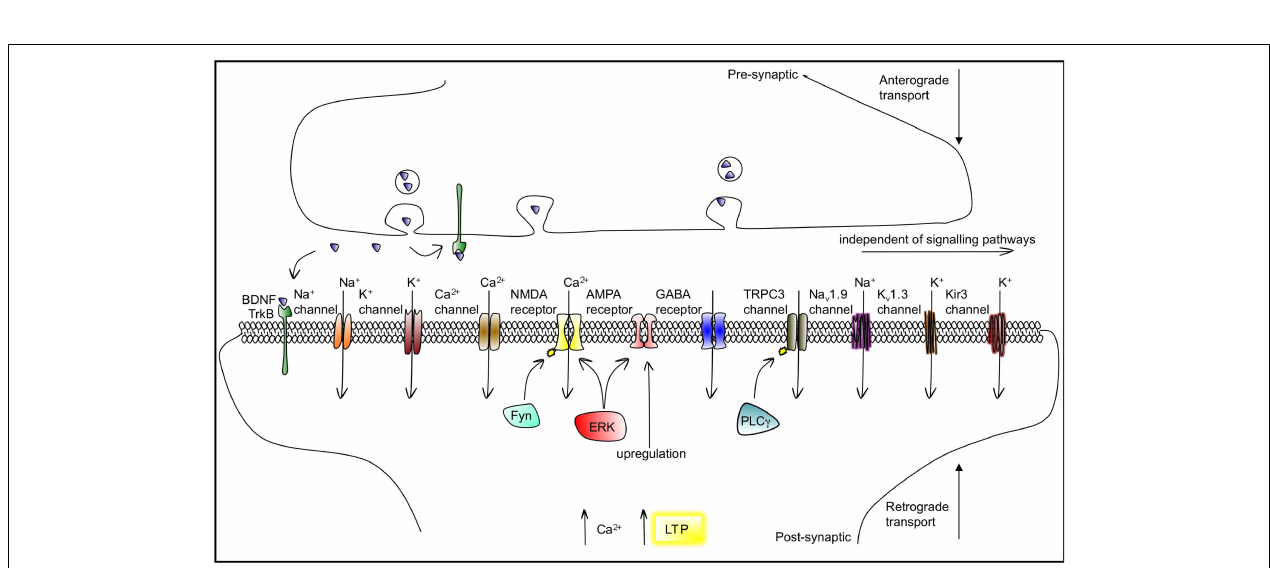
FIGURE 4 | BDNF/TrkB actions on ligand-gated, voltage-gated and second-messenger-gated ion channels, which mediate fast and slow synaptic transmission in neurons. BDNF is transported anterogradely and retrogradely and can activate TrkB receptors both pre- and postsynaptically. The association of BDNF with TrkB modulates or activates ion channels including Na + , Ca 2 + and K + channels, within a range of seconds to minutes, through intracellular signalling cascades. TRPC3 is a non-selective cation channel that needs to be phosphorylated by TrkB to